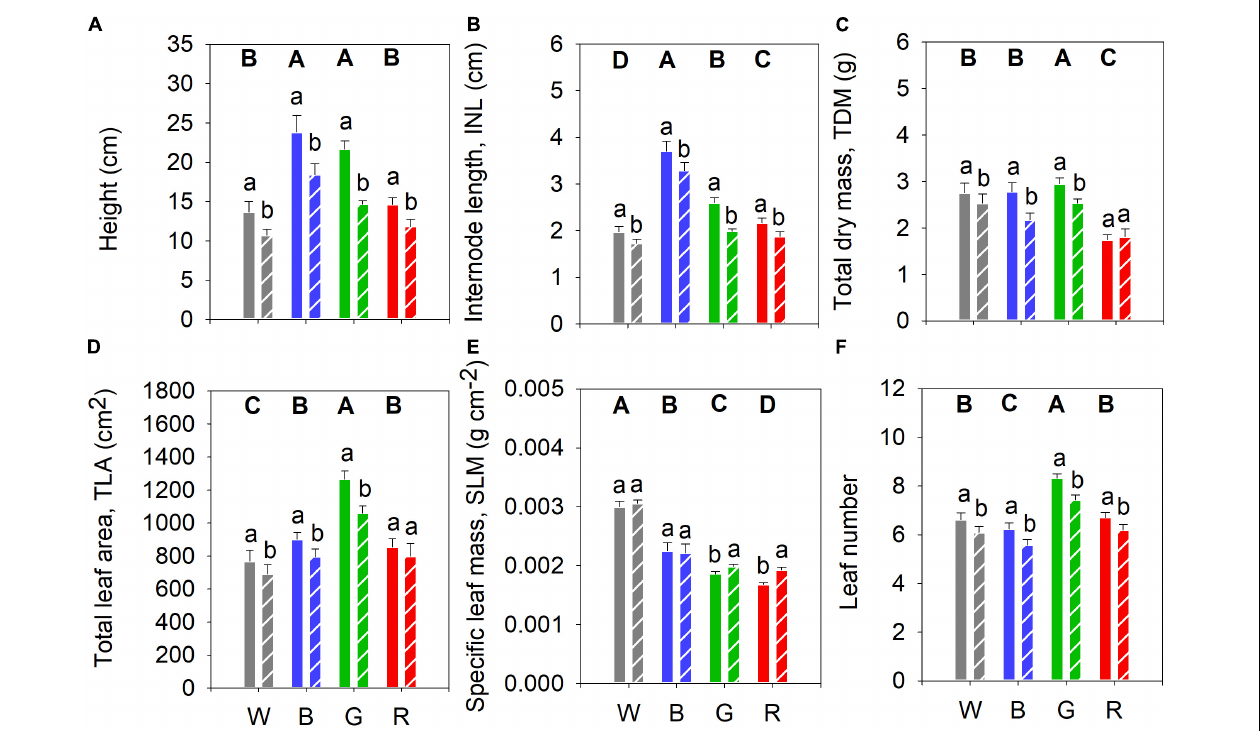
FIGURE 2 | Biomass accumulation of cucumber plants grown under four PAR backgrounds after 14 days without (solid bars) or with (dashed bars) exposure to supplementary UV-B irradiation. (A) Height (cm); (B) Internode length (INL, cm); (C) Total dry mass (TDM, g); (D) Total leaf area (TLA, cm 2 ); (E) Specific leaf mass (SLM, g cm − 2 ); (F) Leaf number. Data are mean values ( n = 21 ± SE). Capital letters indicate significant differences between growth light qualities without UV-B and lower-case letters between non-UV-B-exposed plants and UV-B-exposed plants within the same light backgrounds, both at P <